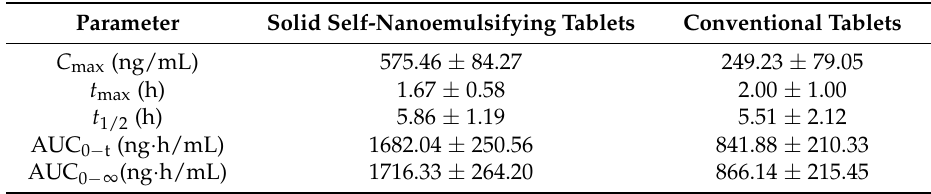
Table 7. Pharmacokinetic parameters of VK1 in beagle dogs after a single oral administration of solid self-nanoemulsifying VK1 tablets and conventional VK1 tablets ( n =